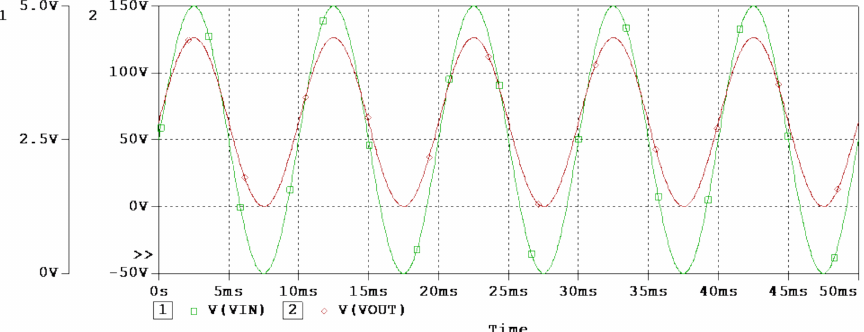
Figure 12. Simulated sinusoidal input–output response for the power amplifier using high-voltage operational